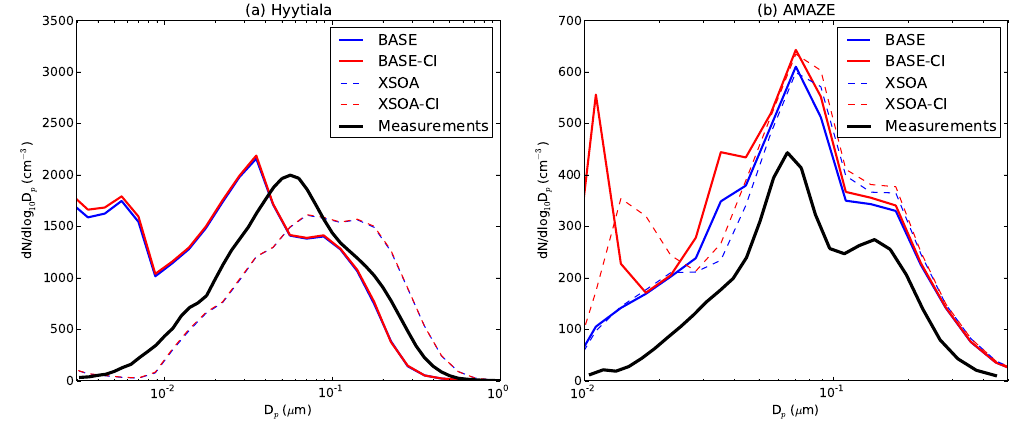
Fig. 8. (a) Measured and modelled (BASE, BASE-CI, XSOA and XSOA-CI) annual-mean aerosol size distribution at Hyyti¨al¨a for 2001. (b) The same but for the AMAZE campaign in the central Amazon during February and